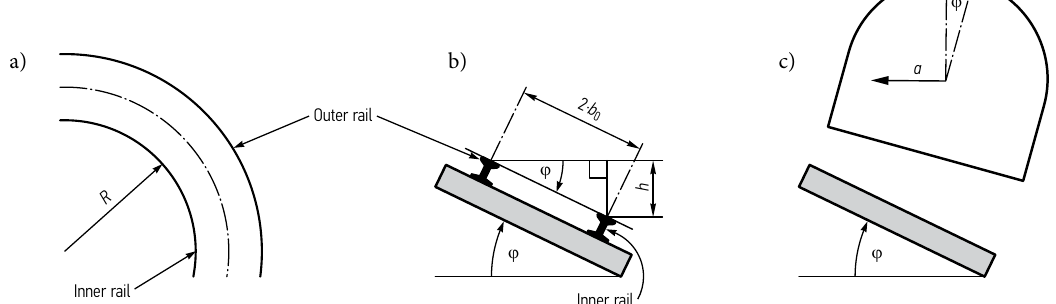
Fig. 1. The curve in plane and longitudinal profile: R – curve radius; φ – superelevation angle; h – superelevation; 2· b 0 – the distance between rail axes (when a track gauge is 1435 mm, the value is equal to 1.500 m; when a track gauge is 1520 mm, the value is equal to 1.535 m); a – lateral